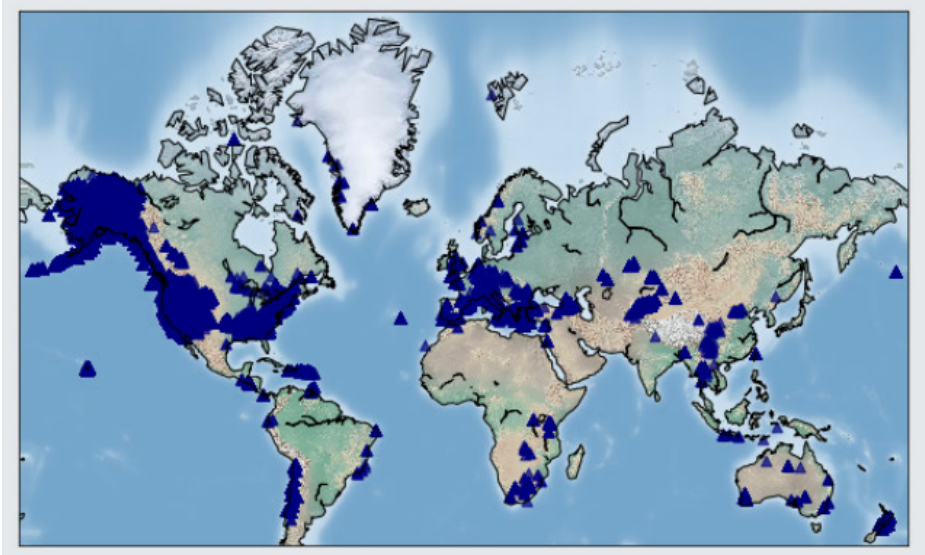
Figure 1. A distribution map of the seismic instruments (the dark blue triangles show the locations of the seismic instruments that recorded the